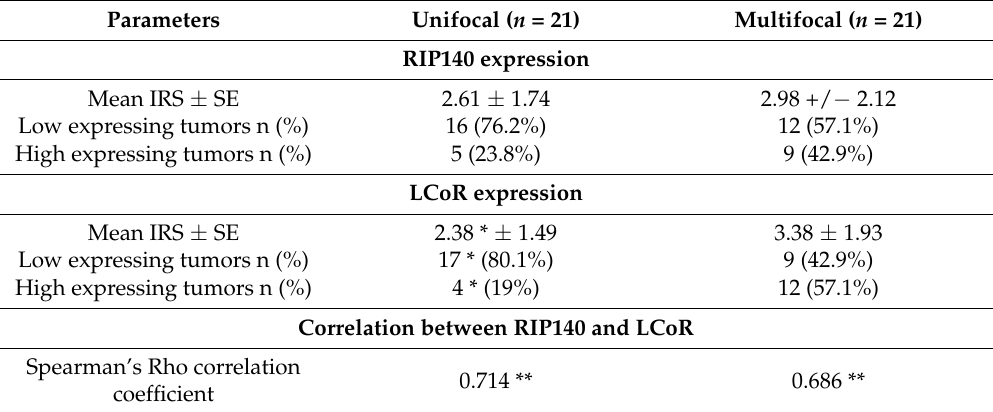
Table 2. Distribution and correlation of RIP140 and LCoR expression in unifocal versus multifocal breast cancers.